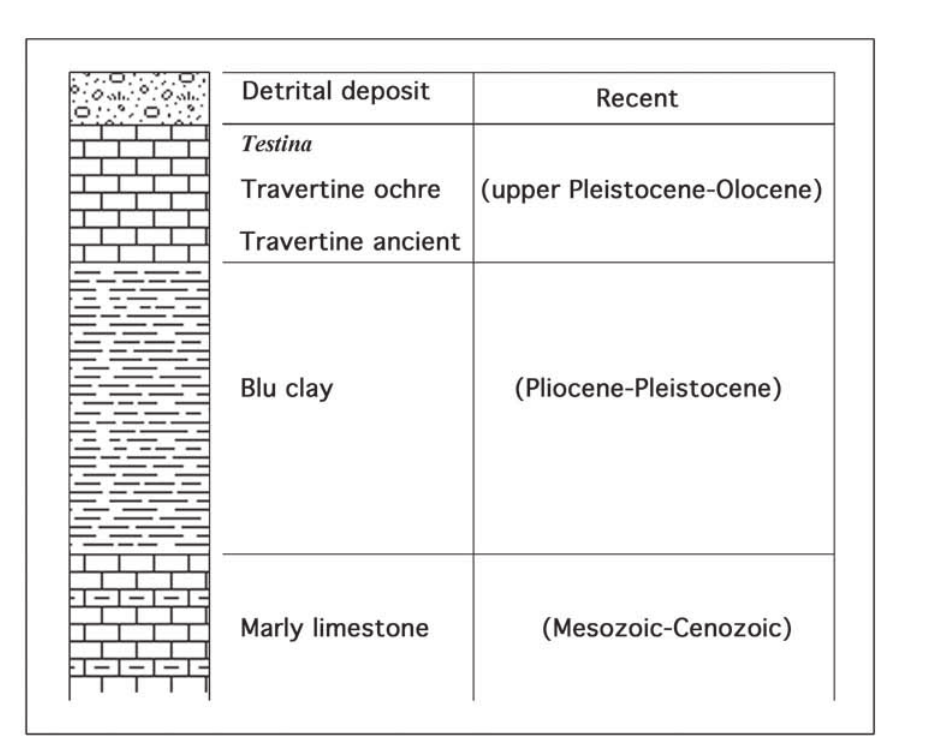
Fig. 3. Lithological sequence of the travertine basin. Notice that this scheme is purely indicative of the main lithotypes. Moreover the thicknesses is strongly dependent on the